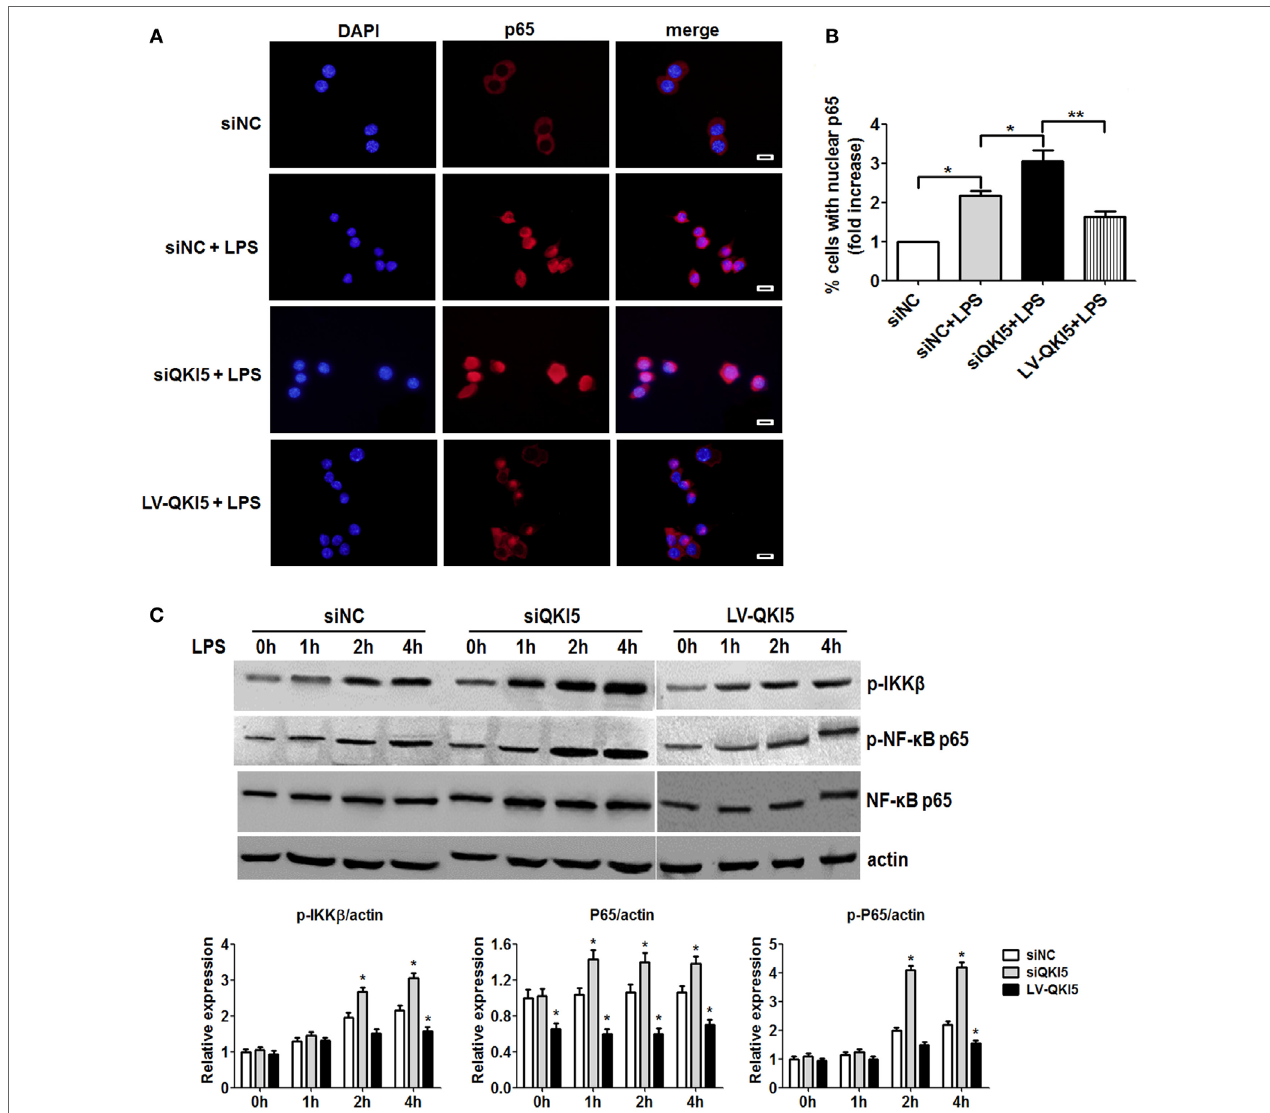
FigUre 3 | Lack of quaking (QKI)-enhanced lipopolysaccharide (LPS)-induced nuclear translocation and phosphorylation of NF- κ B. (a) QKI-silenced or overexpressed RAW 264.7 cells were treated with 1 µg/ml LPS for 2 h. Immunostaining for p65 (red) was performed. DAPI staining is shown in blue. Scale bar, 20 µm. (B) Graphs show the percentage of macrophages with nuclear p65 (fold increase) in (a) . Briefly, 100 randomly chosen cells were counted and categorized into two groups according to the subcellular distribution of p65, including nuclear or cytoplasmic. (c) QKI-silenced or overexpressed RAW 264.7 cells were treated with 1 µg/ml LPS for the time indicated. One representative western blot of phospho-IKK β , phospho-NF- κ B p65, and total NF- κ B p65 is shown. All the bars represent the mean of measurements from three independent experiments, and the error bars indicate ± SEM. * p < 0.05, ** p < 0.01 versus siNC